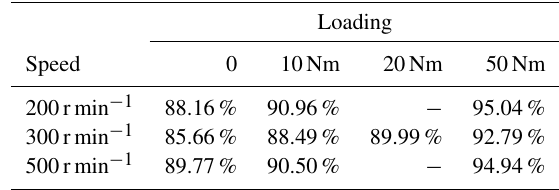
Table 3. Average transmission efficiency in the acceleration pro-